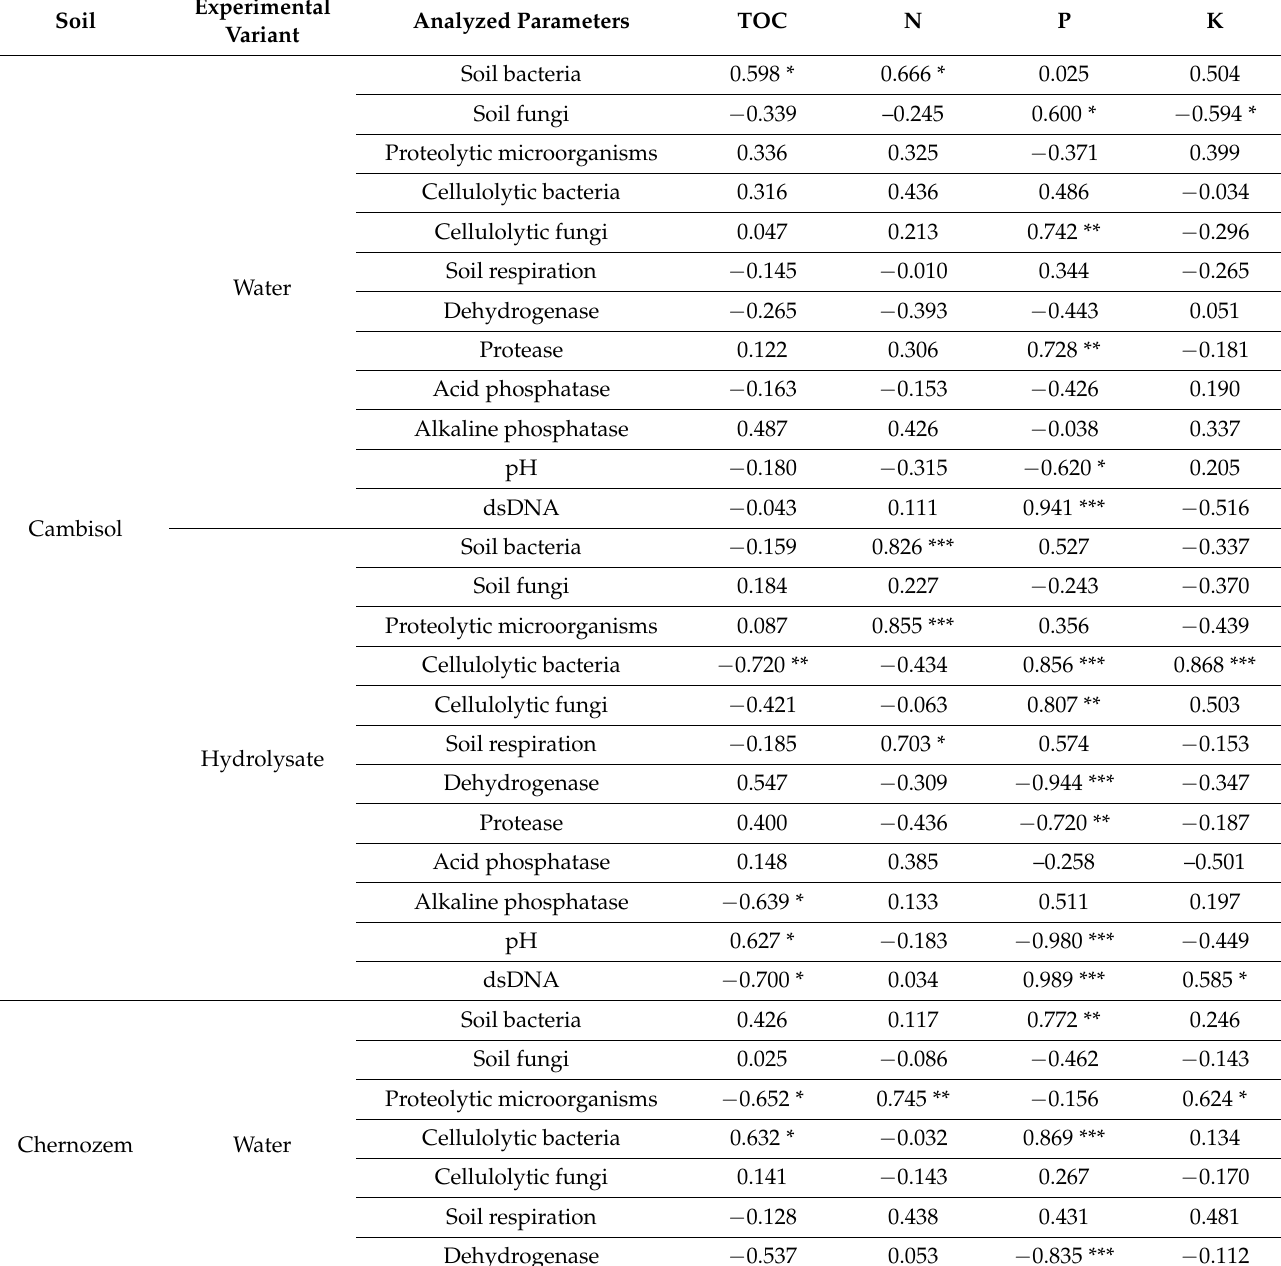
Table 5. The values of r–Pearson’s correlation coefficients between microbiological, biochemical, and chemical